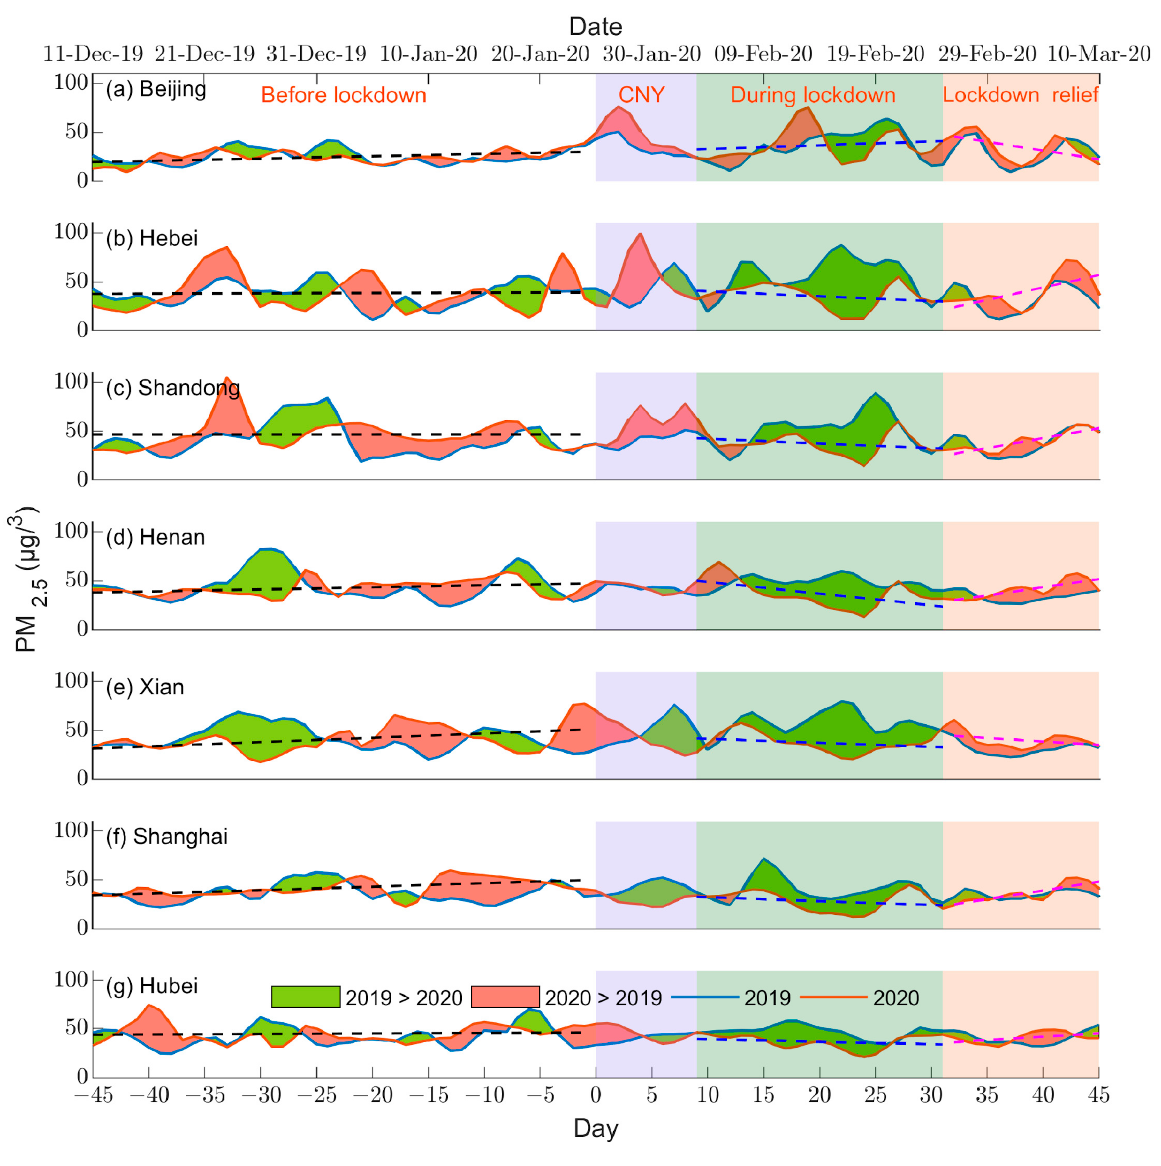
Figure 8. Time series of daily PM 2.5 values across seven study regions of China, comparing equivalent periods in 2019 and 2020. The times when PM 2.5 concentrations are higher in 2019 than in 2020 are shaded in yellow-green, while the times when PM 2.5 concentrations are higher in 2020 than in 2019 are shaded in salmon. Trends are also plotted for the three separate periods of before lockdown, during lockdown and after lockdown for 2020.